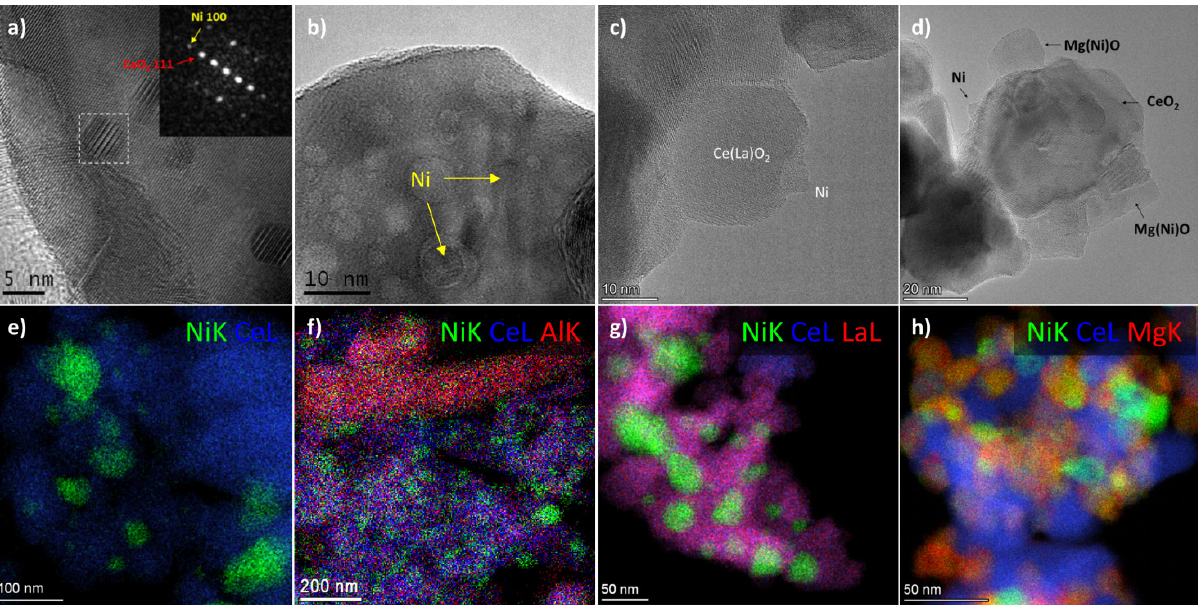
Figure 25. HRTEM pictures ( a – d ) and EDX mapping ( f – h ) of spent Ce 0.8 Ni 0.2 O 1.8 ( a , e ) and (CeM) 0.8 Ni 0.2 O y (M = Al ( b , f ), La ( c , g ), Mg( d , h )) samples. M/Ce molar ratio is equal to 1.